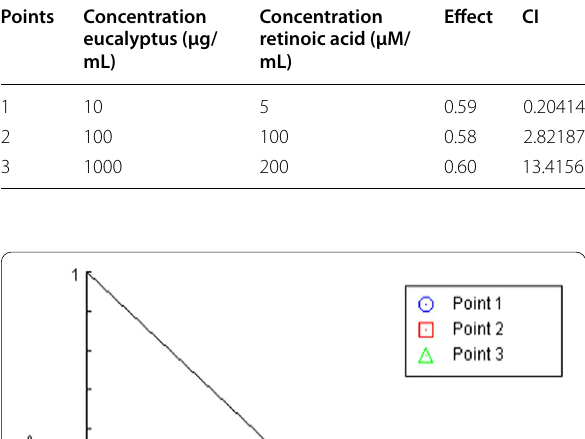
Table 2 Value of CI for non‑constant combination (EU esophagus carcinoma SK‑GT‑4 treated for 72 h ( n